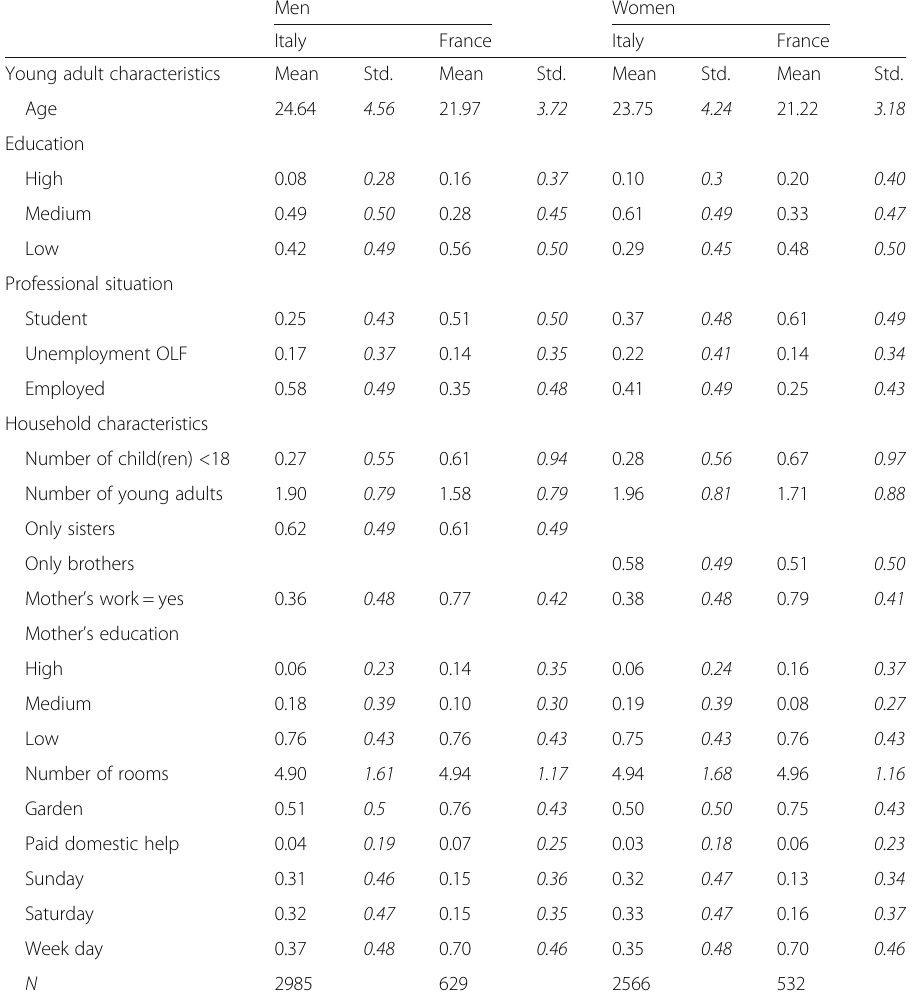
Table 1 Description of young adults living with parents Men Women Italy France Italy France